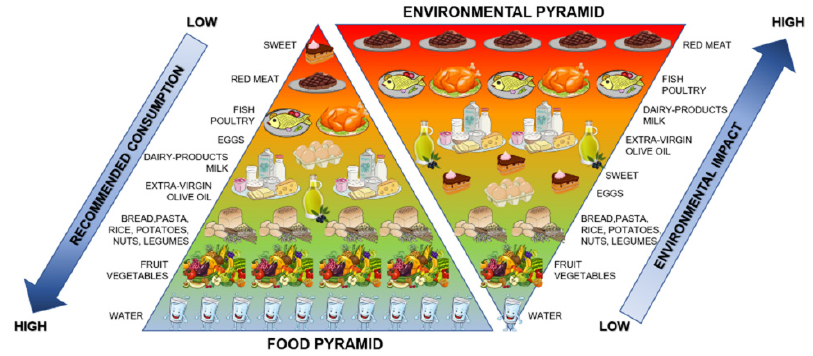
Figure 1. Double “food and environmental” pyramid.